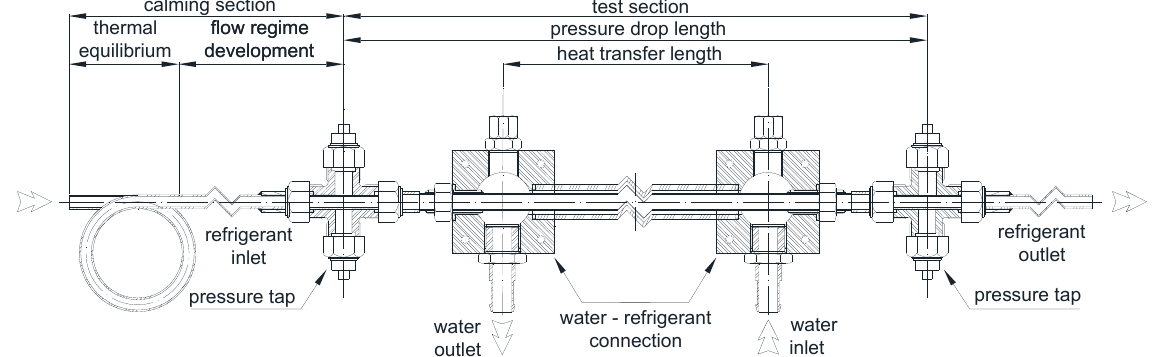
Figure 2. Main components of the calming section and the test section.